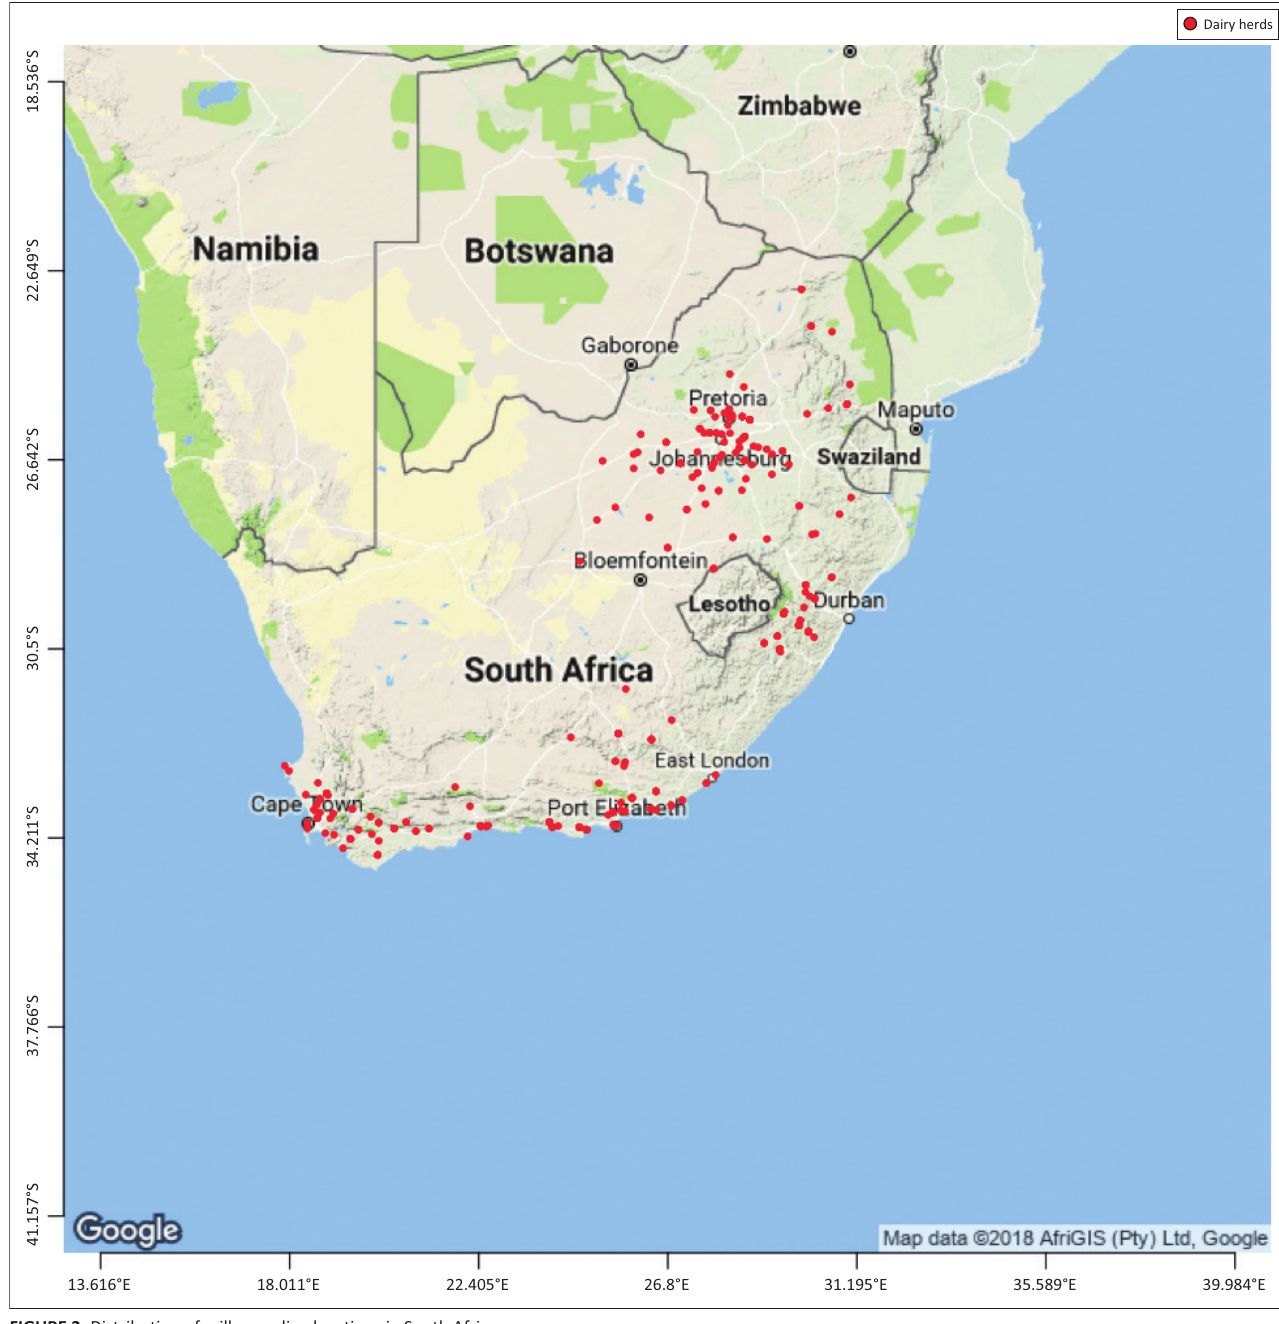
FIG URE 2: Distribution of milk sampling locations in South